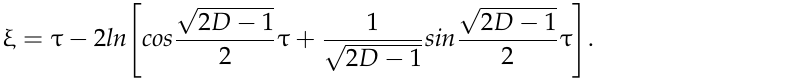
. ξ = ( B / η ) . ε ( b ) with respect to